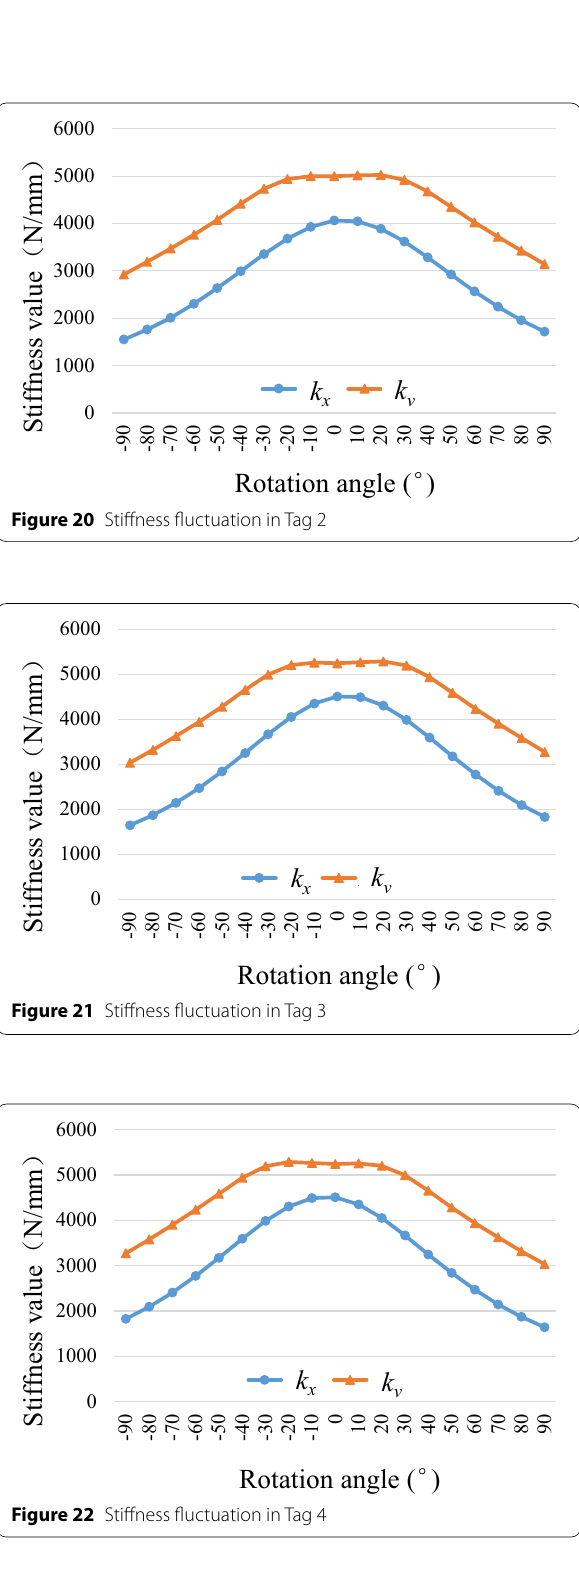
20°. Similarly, two peaks formed in Tags 2 and 3 at θ x = − 10° and θ x 20°, respectively, and the optimal k v was = − = observed at θ x 20°. =